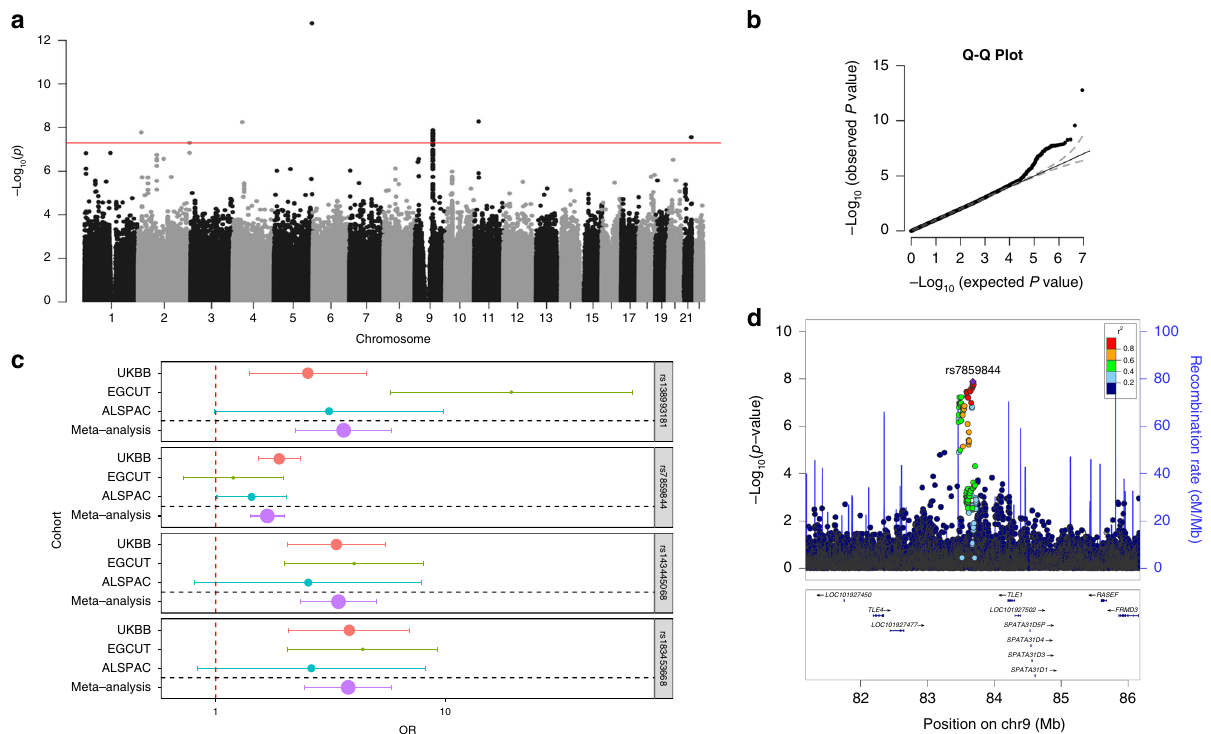
Fig. 3 Results of the multiple consecutive miscarriage GWAS meta-analysis. a , b Meta-analysis results were fi ltered to keep variants with an average MAF ≥ 0.5%, cohort-level MAF ≥ 0.1%, and that were present in at least two cohorts ( n = 8,956,146); c Four of the genome-wide signi fi cant signals (rs138993181 on chromosome 2, rs7859844 on chromosome 9, rs143445068 on chromosome 11, and rs183453668 on chromosome 21) were present in all three cohorts ( n cases = 750, n controls = 150,215) and had the same direction of effect, effect estimates from Firth test. OR-s (dot) and 95% CI-s are plotted (error bars), the size of the dot is proportional to the effective sample size. d Regional plot of the association signal on chromosome